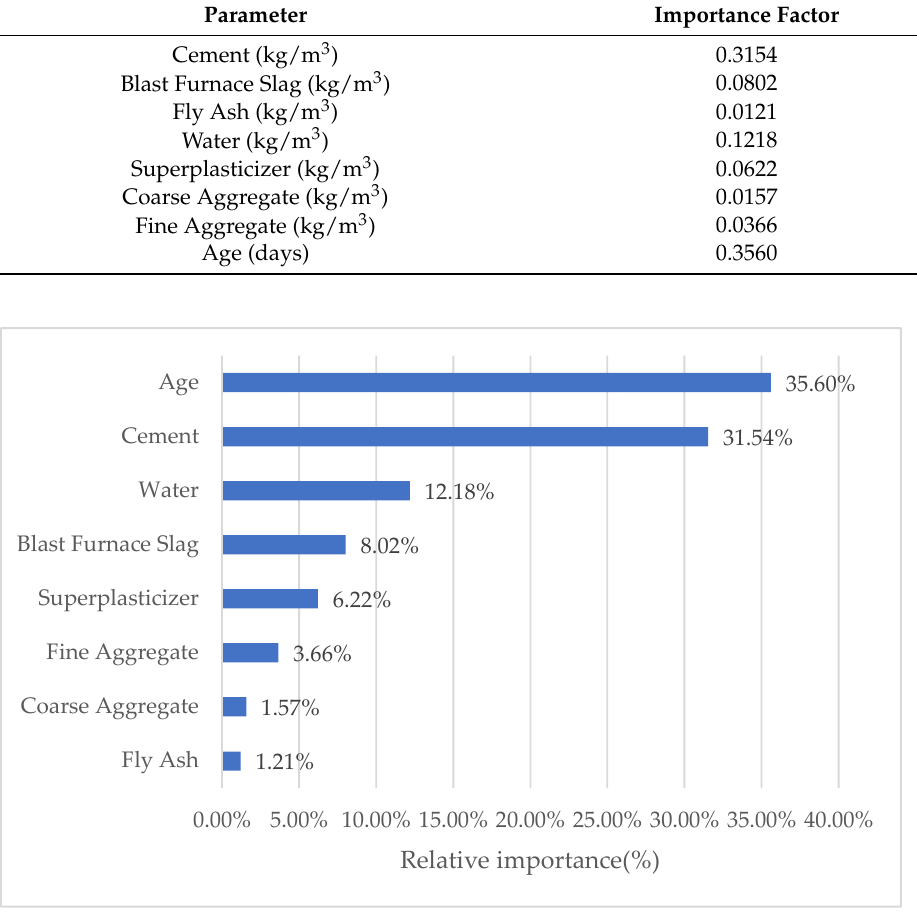
Figure 17. Relative importance of the input parameters.